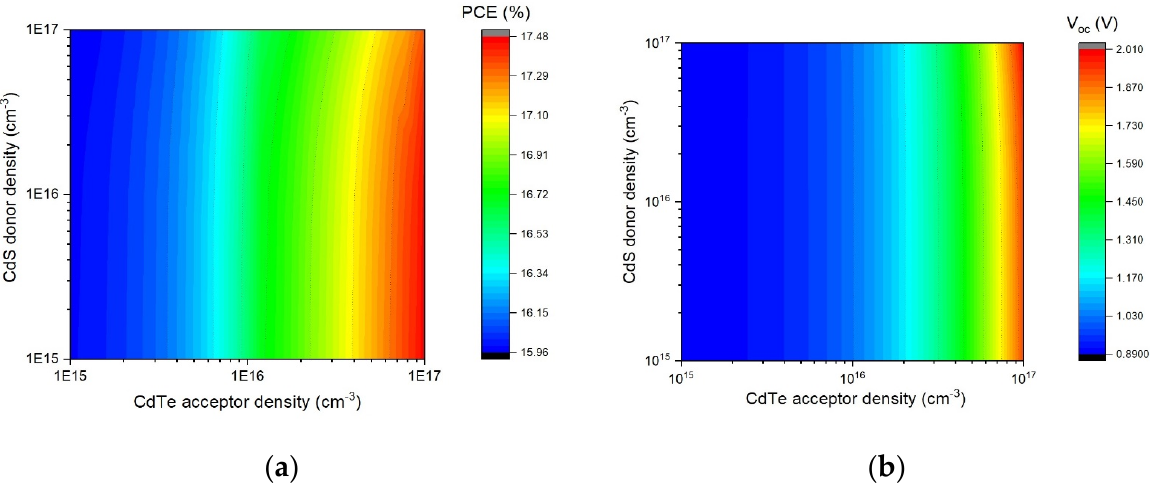
Figure 8. Effect of carrier concentration on CdTe solar cell performance: ( a ) PCE and ( b ) Voc.